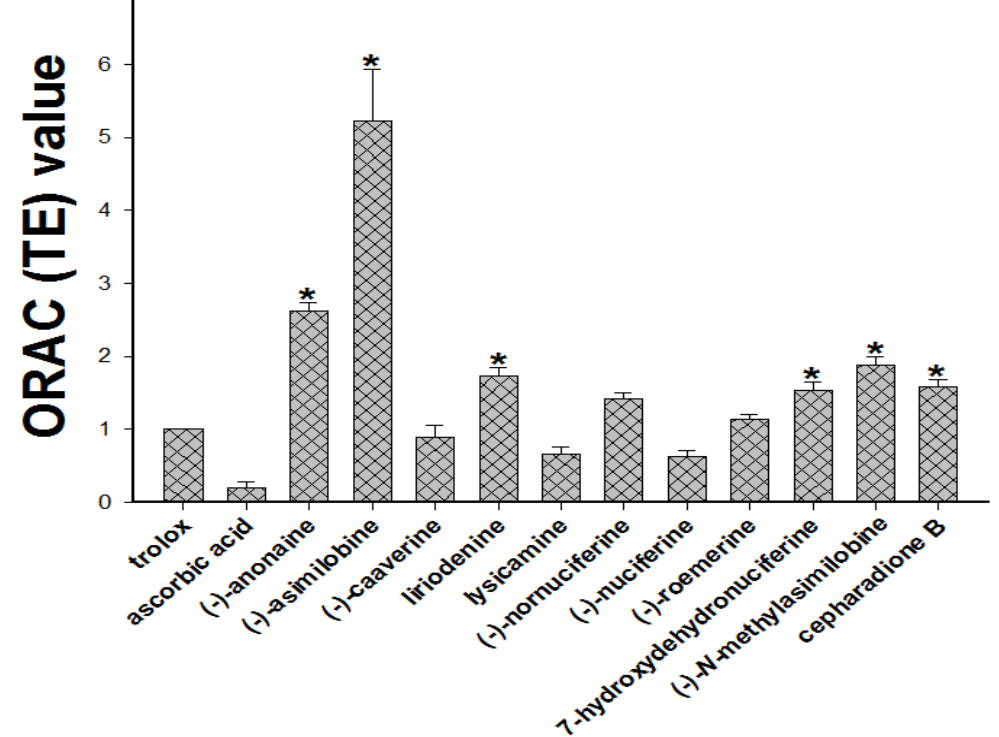
by subtracting the area under the blank curve. Trolox and ascorbic acid were used as a positive control. The results represent the mean ± SD for three independent